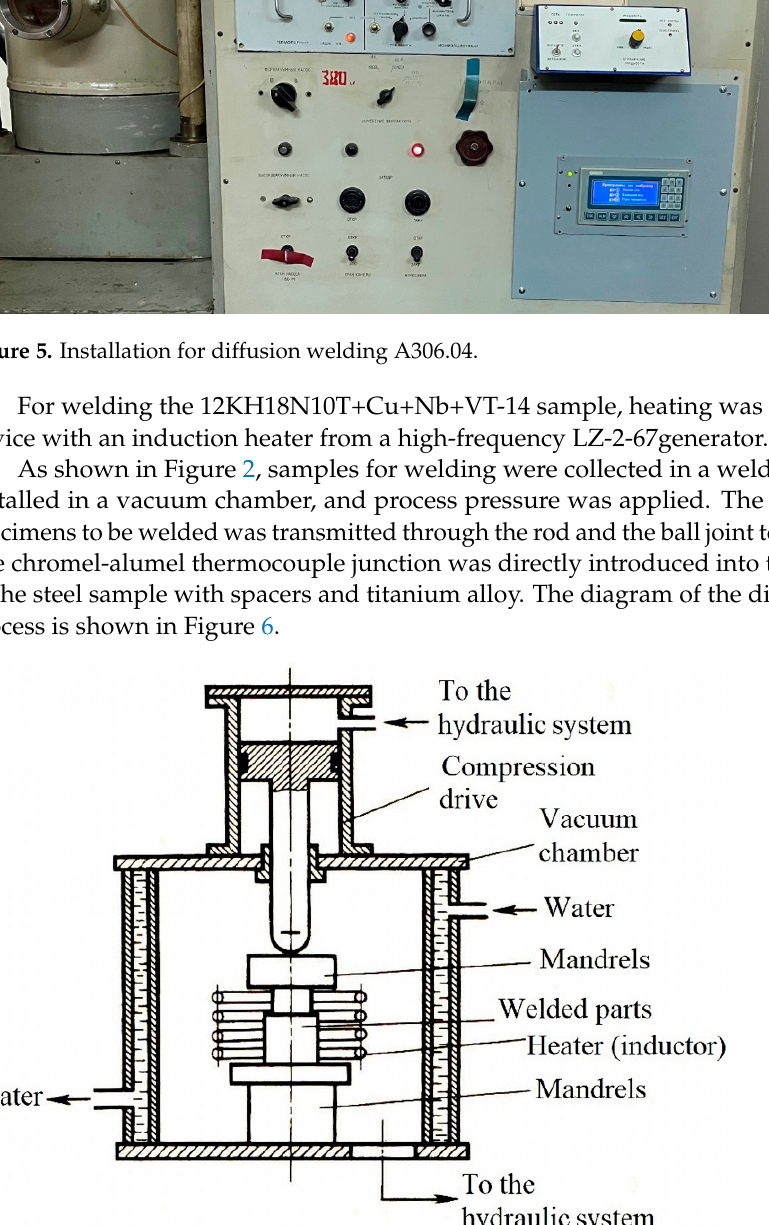
Figure 4. Standard sample No. 4 for mechanical tests turned from a 12KH18N10T+Cu+ Nb+VT-14 billet.